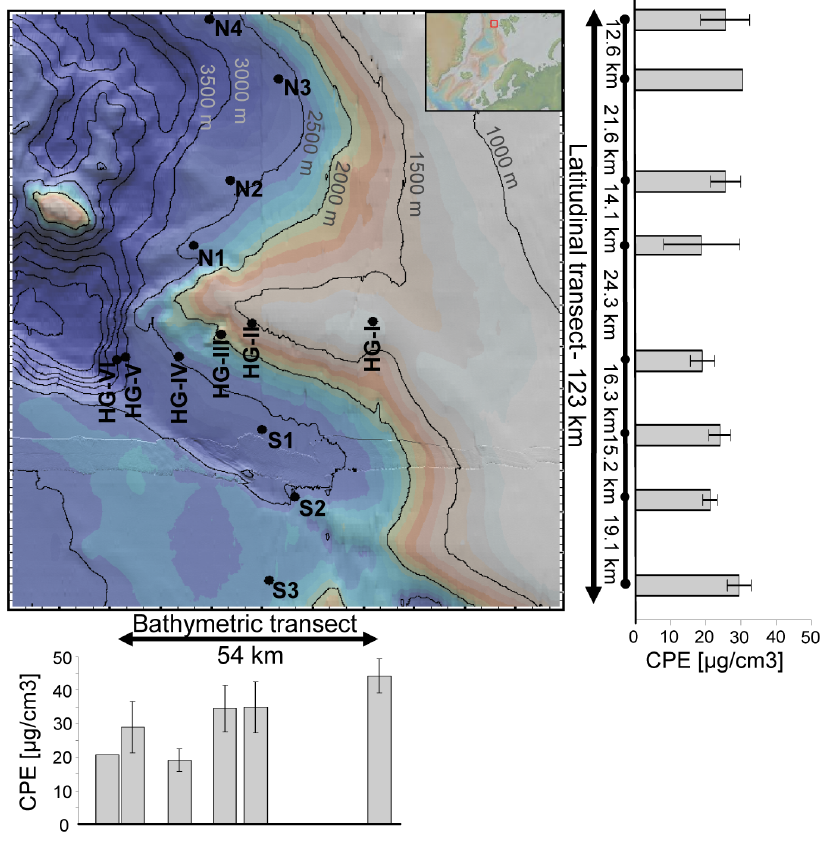
Figure 1. Location of sampling stations of the LTER site HAUSGARTEN and corresponding pigment concentrations (CPE). Distances in km between sampling stations were calculated from latitude or longitude only for the latitudinal and bathymetric transect, respectively. Map created with GeoMapApp [70].